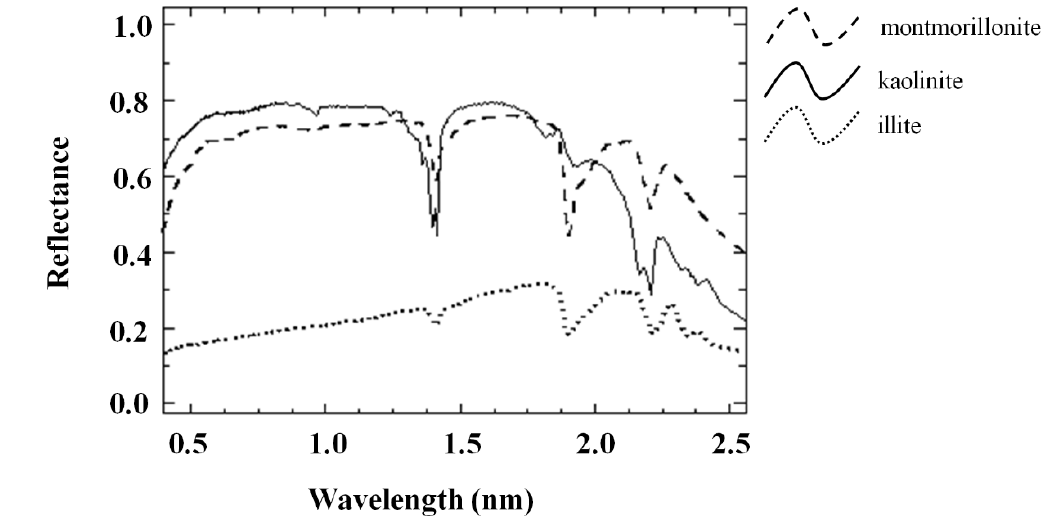
Figure 5. Typical spectra of montmorillonite, illite, and kaolinite obtained from the spectral library [24]